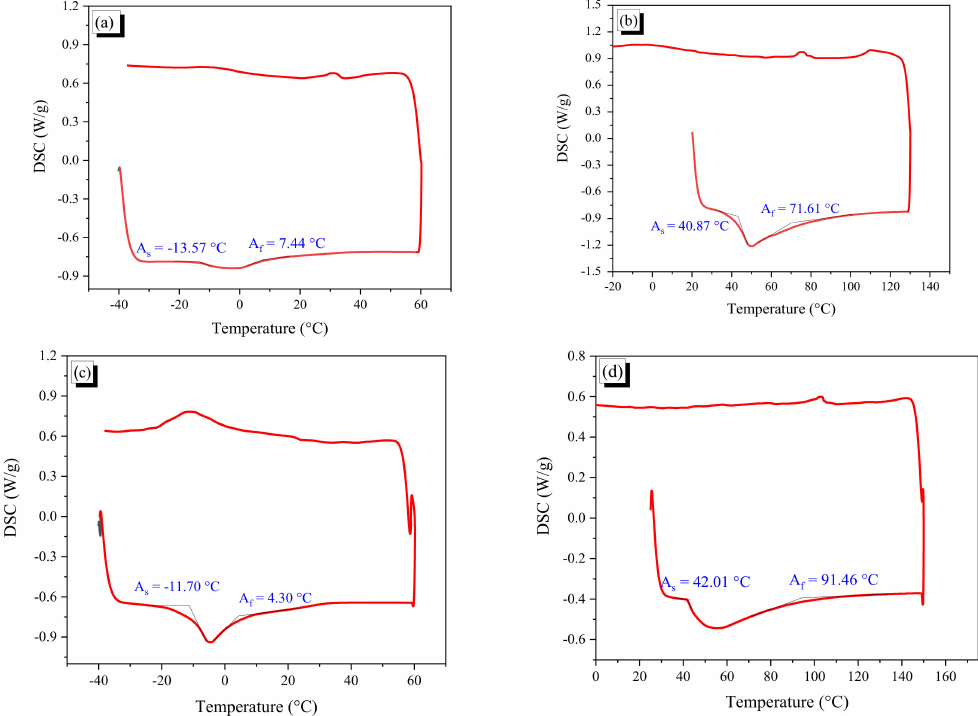
Figure 1. DSC curves of SMA fibers before and after cold drawing: ( a ) AR1.0 fiber before cold drawing; ( b ) AR1.0 fiber after cold drawing; ( c ) AR0.7 fiber before cold drawing; and ( d ) AR0.7 fiber after cold